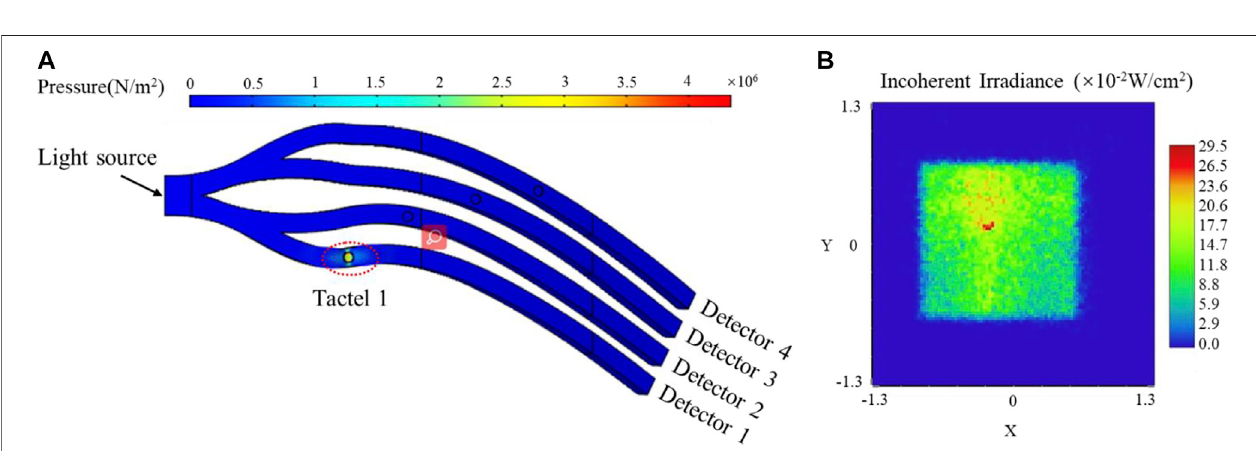
FIGURE 4 | The simulation results of channel 1 with 1,500 kPa applied. (A) Deformation, (B) The inherent radiation distribution map.